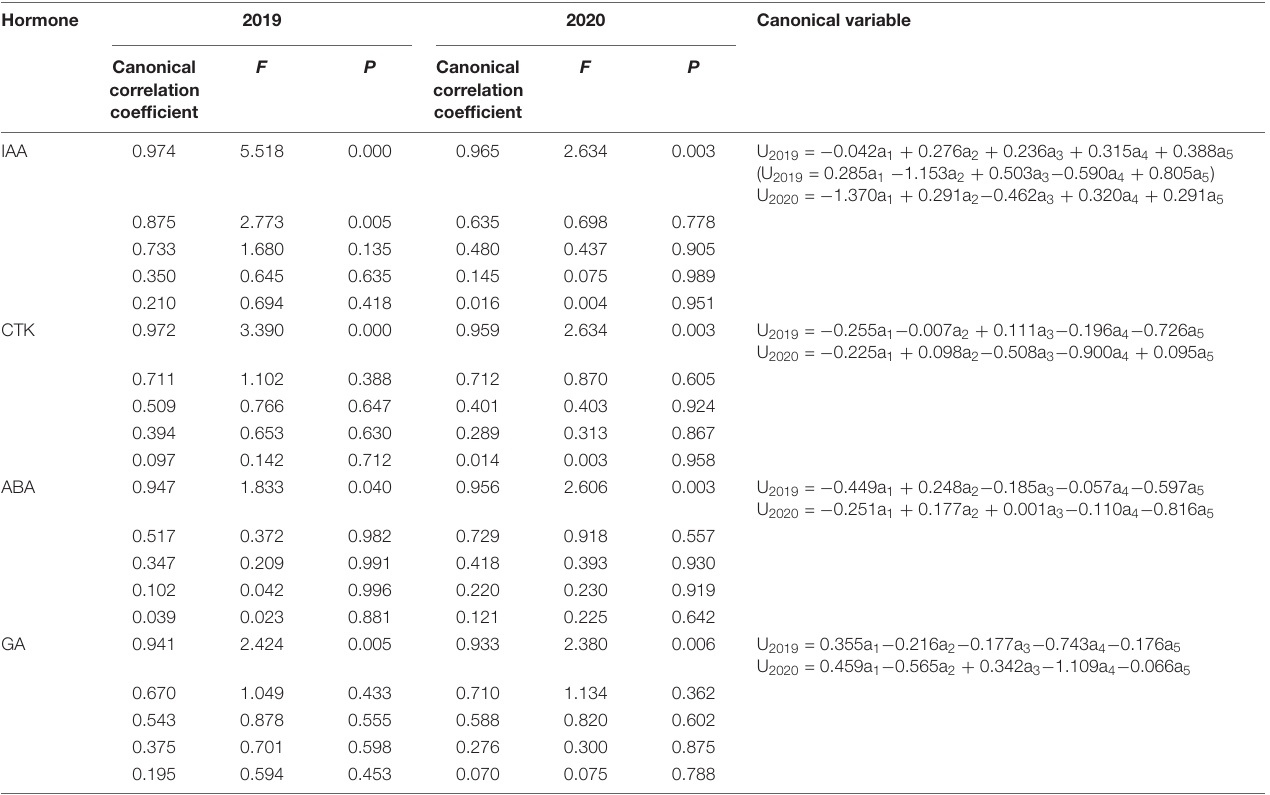
TABLE 6 | Canonical correlation coefficient between grain-filling parameters and hormone content and standardized analytical model.